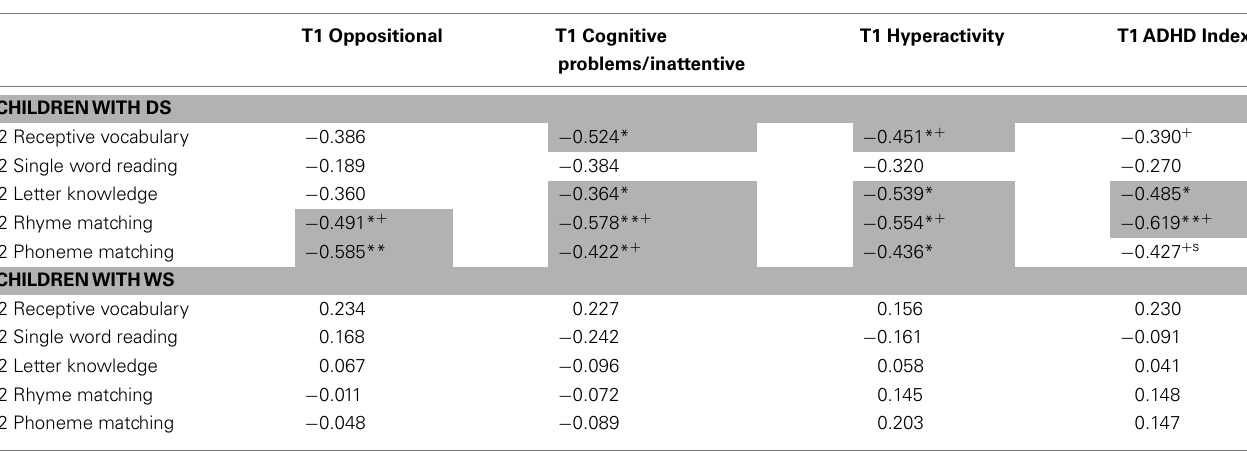
Table 6 | Longitudinal Pearson